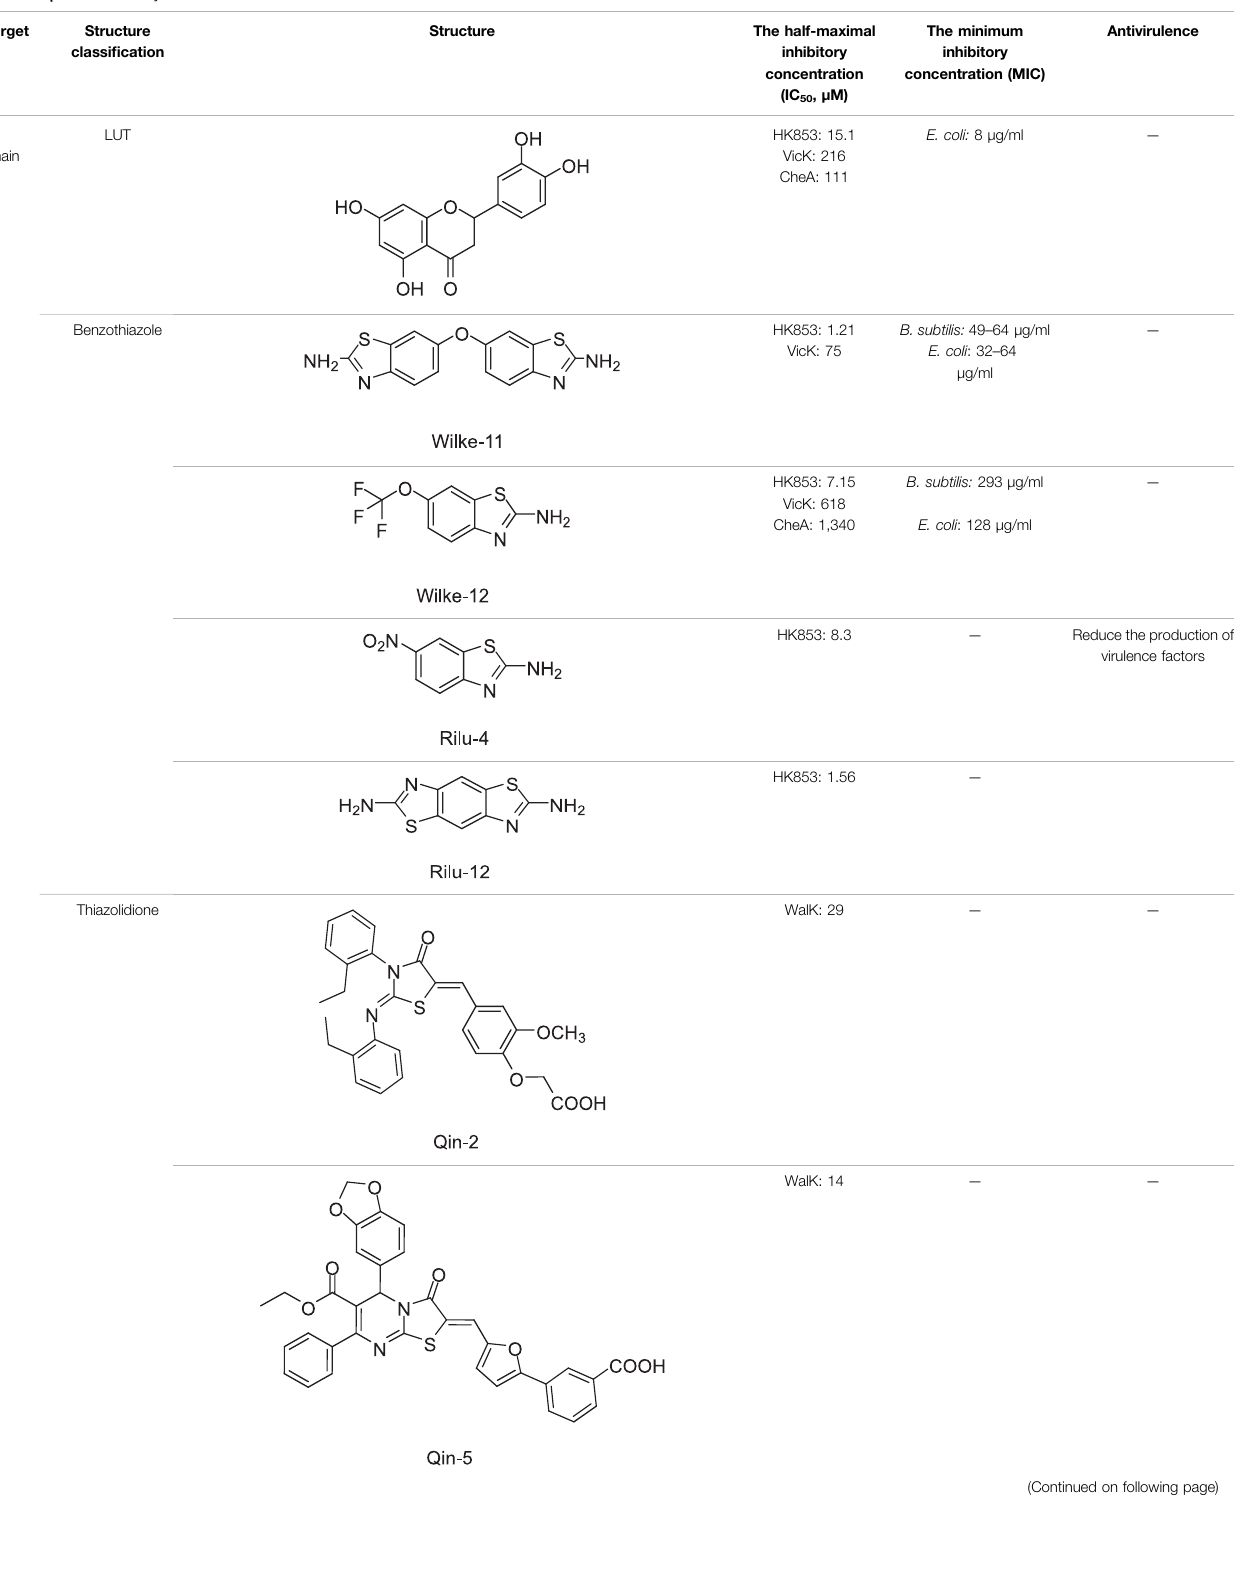
TABLE 4 | The summary of HK